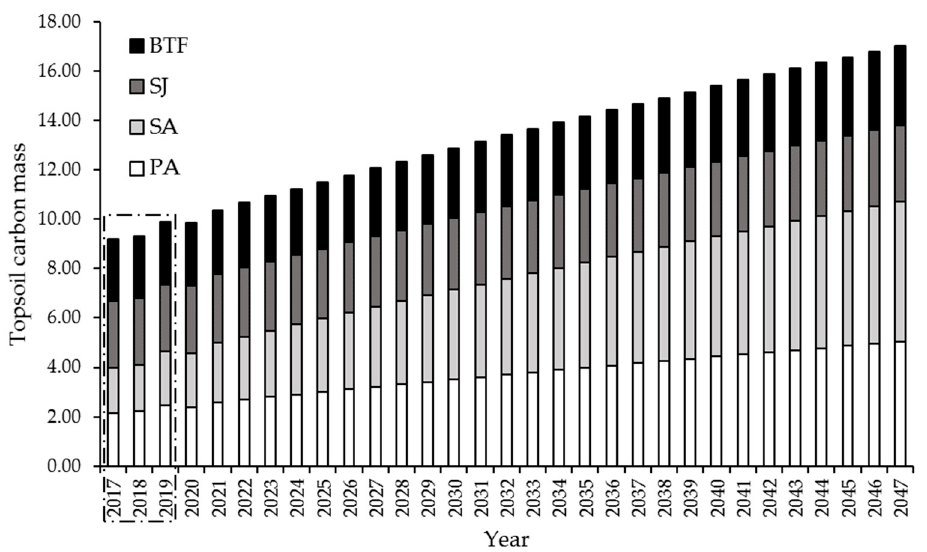
Figure 3. Model simulations (2017–2047) of topsoil carbon mass (in kgC m − 2 yr − 1 ) at 25 cm depth at the four experimental sites– Phragmites australis (PA), Spartina alterniflora (SA), Suaeda japonica (SJ), and Bare Tidal Flat (BTF) in Ganghwa province of Korea. The years (2017, 2018, and 2019) identified within the rectangle confirms the